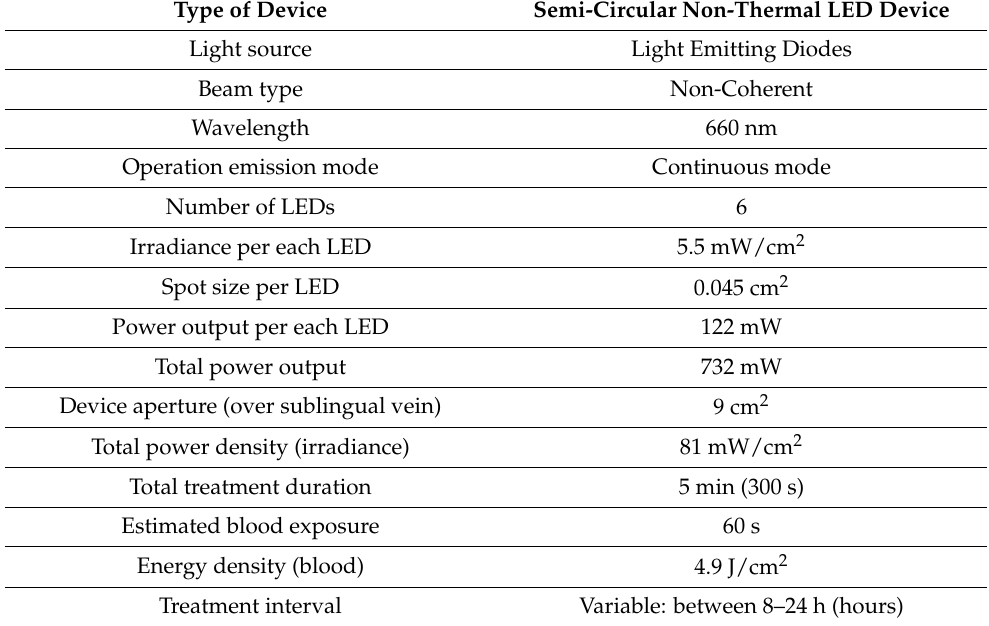
Table 3. Shows the device description and LED dosimetry and treatment protocols for sublingual photobiomodulation